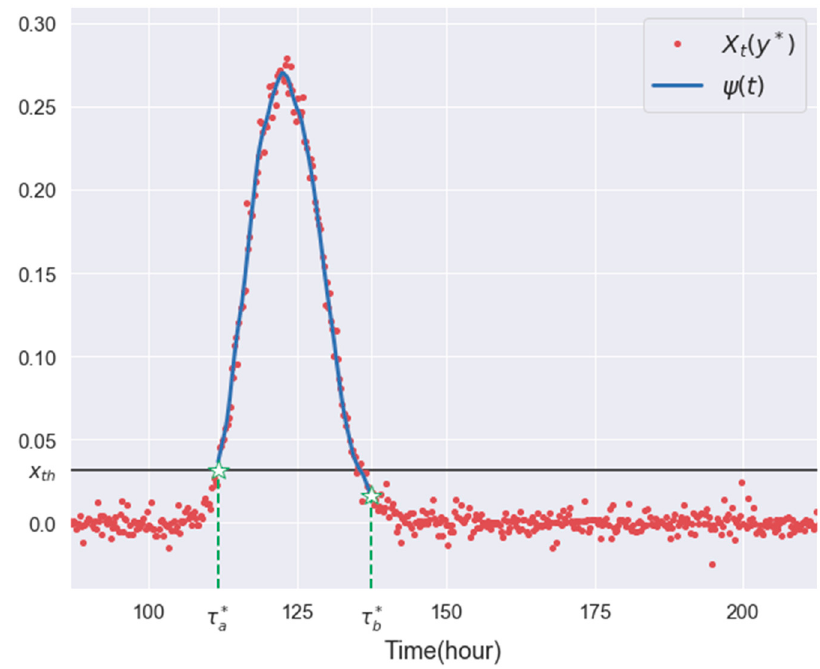
∗ ) , τ ∗ τ ∗ , and ψ ( t ) a , b